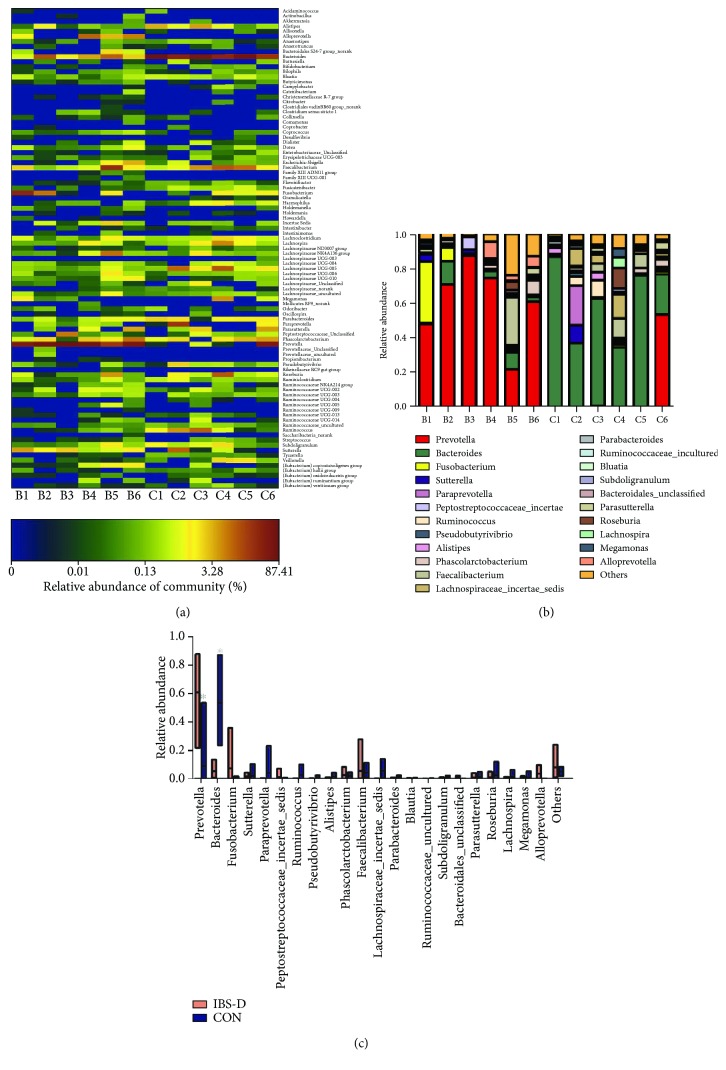
IBS-D patients show significant differences in fecal bacterial composition by high-throughput sequencing compared with healthy controls. (a) Heatmap of fecal microbiota in IBS-D patients and healthy controls. There are significant differences in bacterial community profiles at the genus level between IBS-D patients (n = 6) and healthy controls (n = 6). Each column represents one subject. C: control subjects; B: IBS-D patients. (b) Relative abundance of phylotypes at the genus level. (c) Differences in the relative abundance of phylotypes between IBS-D patients and healthy controls. IBS-D patients showed an abundance of Prevotella while Bacteroides predominates in healthy controls. ∗p < 0.05 versus control.